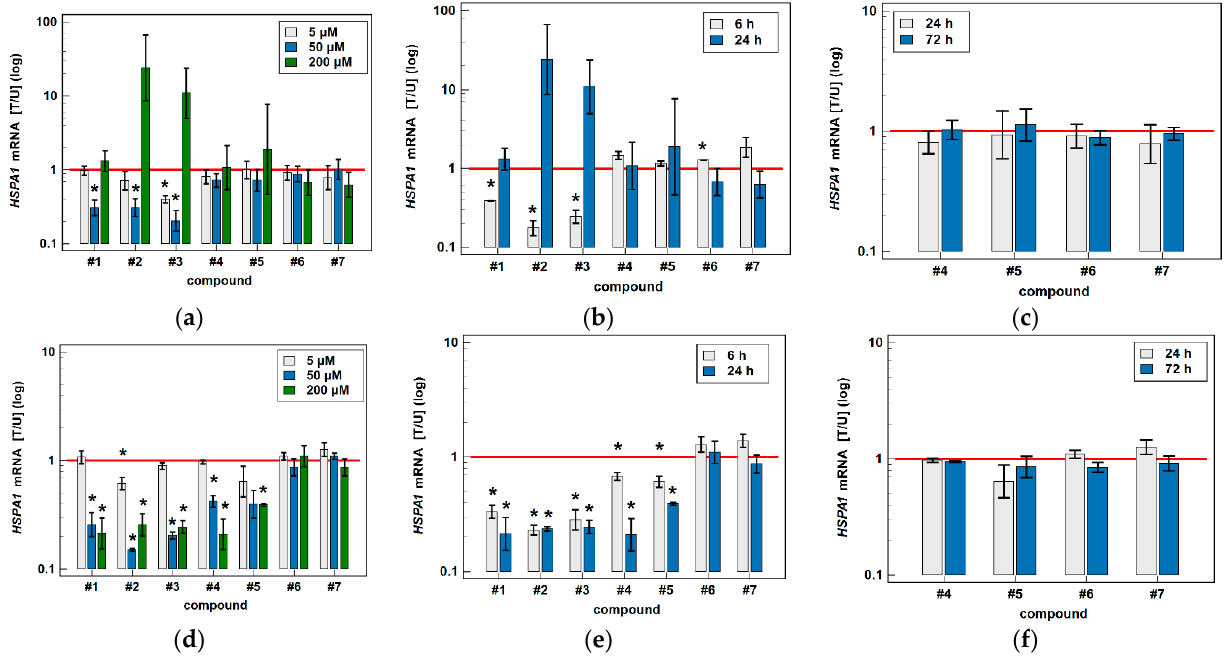
Figure 9. Effect of oxicams on HSPA1 expression in colorectal adenocarcinoma cell lines: ( a ) dose-dependent effect in Caco-2 cells treated for 24 h; ( b ) time-dependent effect in Caco-2 cells treated with 200 µM oxicams; ( c ) time-dependent effect in Caco-2 cells treated with 5 µM oxicams; ( d ) dose-dependent effect in HCT 116 cells treated for 24 h; ( e ) time-dependent effect in HCT 116 cells treated with 200 µM oxicams; ( f ) time-dependent effect in HCT 116 cells treated with 5 µM oxicams. Data presented on logarithmic scale. Bars represent mean expression ratio of treated-to-untreated cells [T/U] with 95% confidence interval (whiskers). Statistically significant differences between treated and untreated cells as analyzed by t -test for paired samples are indicated by asterisks (*). Horizontal solid red line represents gene expression in control (untreated samples). Compound #6 denotes piroxicam and #7—meloxicam.